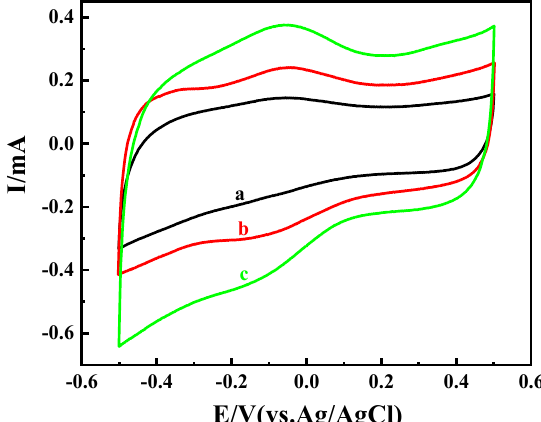
much higher (1.21 times) than that of Nafion/GOxOMC-COOH without glucose (Figure 7B (c,f)), suggesting that it had better electrocatalytic activity. This relative increase indicates Figure 6. CVs (50 mV·s − 1 ) of Nafion/OMC-COOH (a), Nafion/GOx/OMC-COOH (b), and Nafi- on/GOx-NH 2 /OMC-COOH (c) in air-saturated PBS (0.1 M pH 7.4) without glucose. The cyclic voltammogram performed on the bare OMC-COOH electrode, in the ab- sence and presence of glucose, is shown in Figure 7A, while those of Nafion/GOxOMC- COOH and Nafion/GOx-NH 2 /OMC-COOH are shown in Figure 7B,C, respectively. In the absence and presence of glucose, as shown in Figure 7A, there was no obvious peak corresponding to the glucose oxidation in the electrode Nafion/COOH-OMC (a,b), indi-